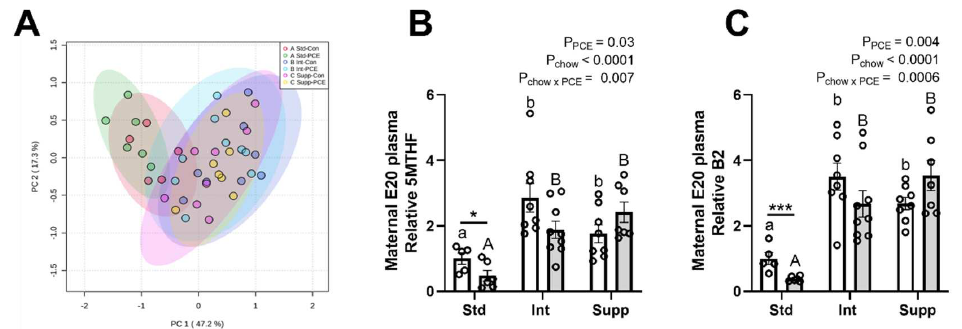
Figure 2. The effects of periconceptional ethanol and choline supplementation on the one-carbon metabolism (1CM) pathway in late gestation maternal plasma. ( A ) Principal components analysis (PCA) of 12 molecules from the 1CM pathway across the 6 experimental groups. Molecules were measured using mass spectrometry. Standard chow (1.6 choline/kg chow, Std) with control (0% EtOH, Con) liquid diet (Std-Con, red); Std with periconceptional ethanol (12.5% v / v EtOH, PCE) liquid diet (Std-PCE, green); intermediate chow (2.6 g choline/kg chow, Int) with Con (Int-Con, dark blue); Int with PCE (Int-PCE, light blue); supplemented chow (7.2 g choline/kg chow, Supp) with Con (Supp- Con, pink); Supp with PCE (Supp-PCE, yellow). Individual analysis of ( B ) 5-methyltetrahydrofolate (5MTHF) and ( C ) vitamin B2. Open bars are Con and grey bars are PCE ( n = 5–9 per group). Data expressed as fold-change relative to the Std-Con group (mean ± SEM). Significant differences were identified via two-way ANOVA and Tukey’s post hoc analysis. * p < 0.05, *** p < 0.001 for differences between Con and PCE within each chow group; chow effects between Con groups are shown by lower-case letters, and between PCE groups by upper-case